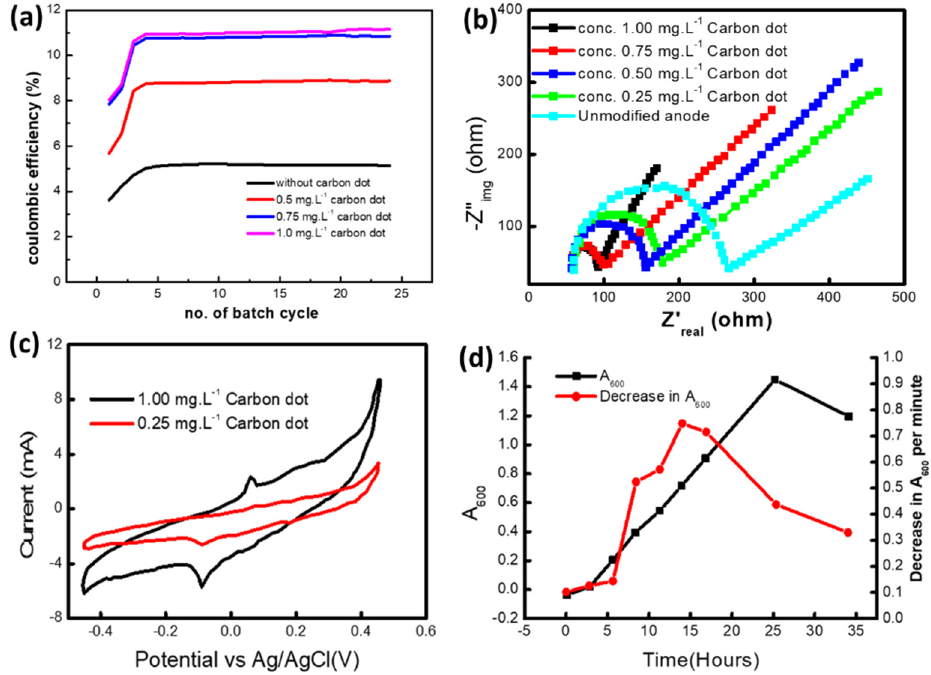
Figure 7. Showing Coulombic efficiency ( a ), impedance spectroscopy ( b ), cyclic voltammetry ( c ), and DREAM assay ( d ) of MFC reactors. CE of the reactor increased with the increase in CD concentrations in the medium. EIS, CV, and DREAM also showed similar observations, where an increased concentration showed higher activity and better performance.